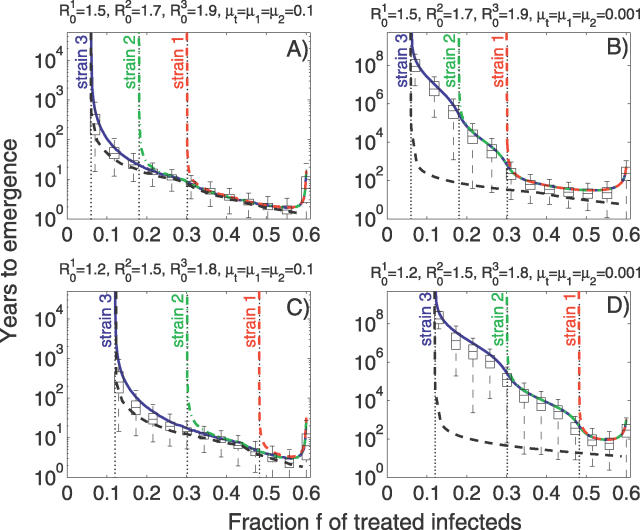
Years until Resistance Emerges—Stochastic ModelBoxplots show distribution of times to emergence (resistance at a level of 5% of total infecteds) for 5,000 simulations of the stochastic model. The red dashed, green dash-dotted, and blue solid lines show the analytic approximations
for the time to emergence of the first, second, and third resistant strain. The vertical black lines indicate the level of treatment at which the fitness of the respective resistant strain is the same as that of the sensitive. For comparison, the black dashed line shows the deterministic result (Equation 7). Parameters are chosen as in Figure 4.